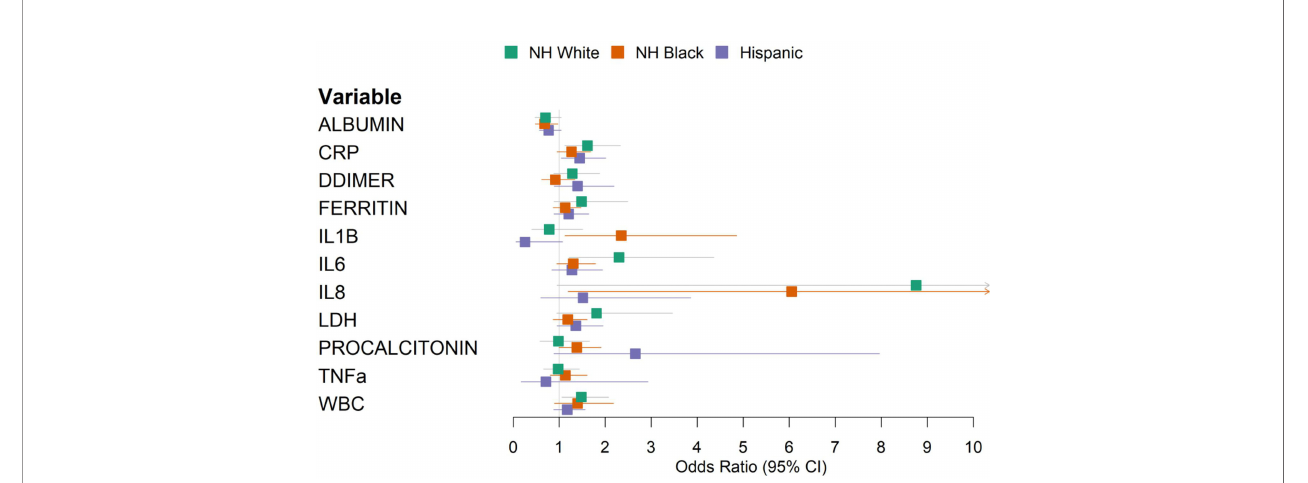
FIGURE 3 | Forest plot of multivariable logistic regression results predicting in-hospital mortality using laboratory values, strati fi ed by race/ethnicity. Models were adjusted for age, sex, and baseline hypoxia.